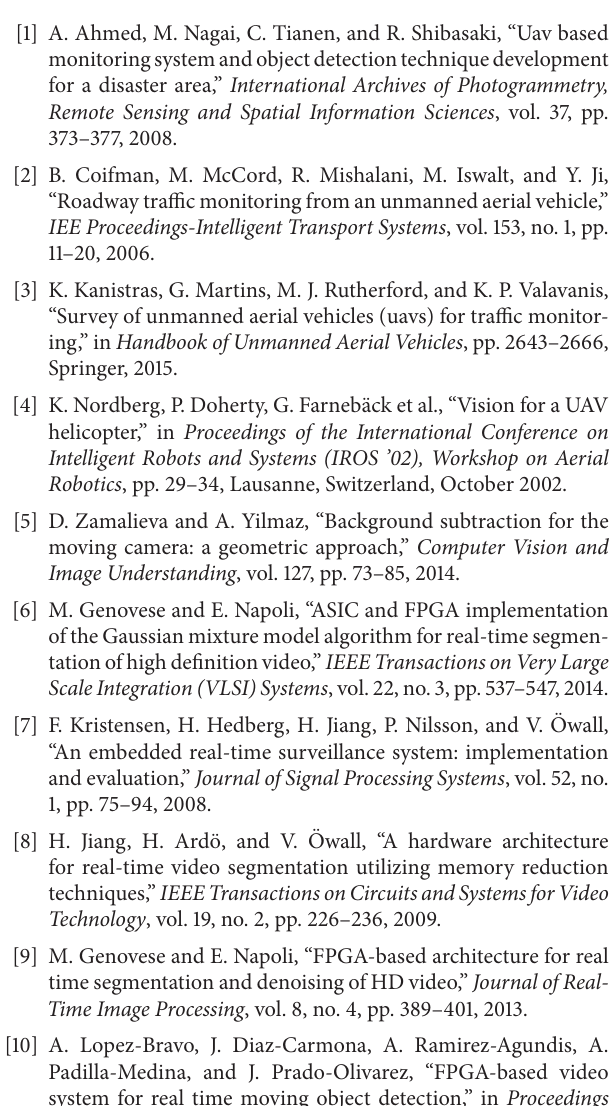
Table 7: Resources usage of the proposed moving target detection SoC. Total combinational function 15161 Embedded